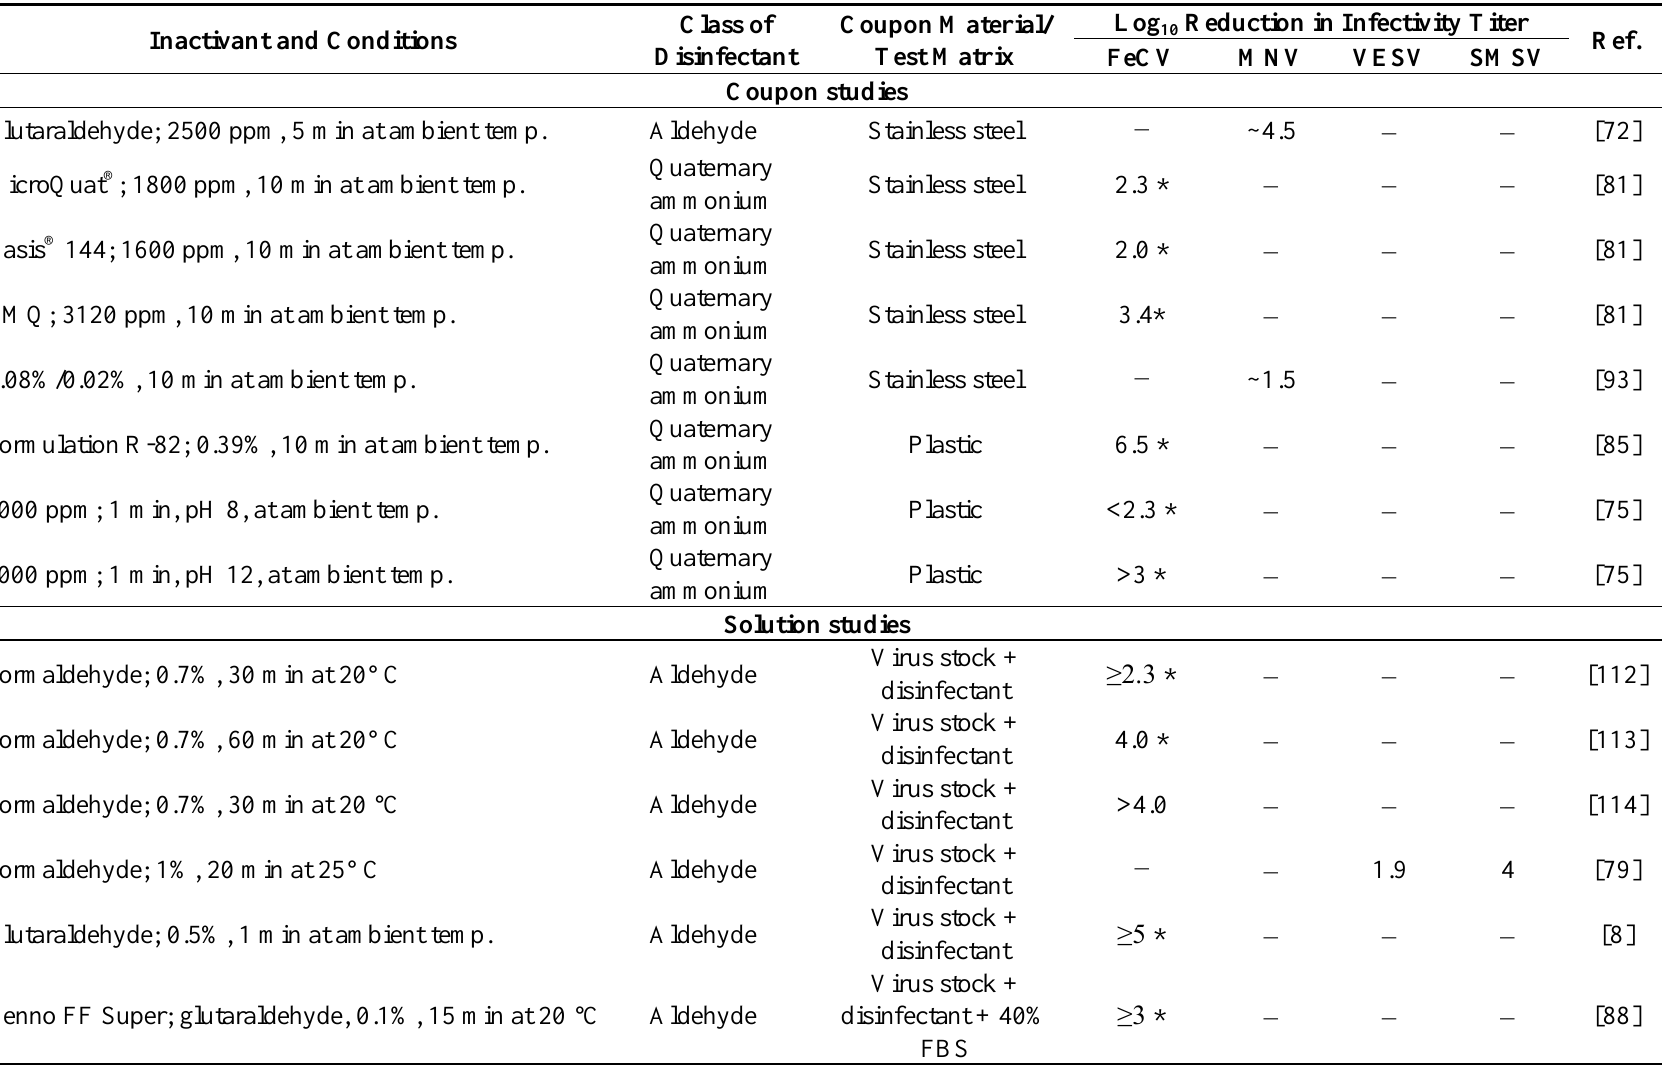
Table 8. Inactivation of caliciviruses by other classes of